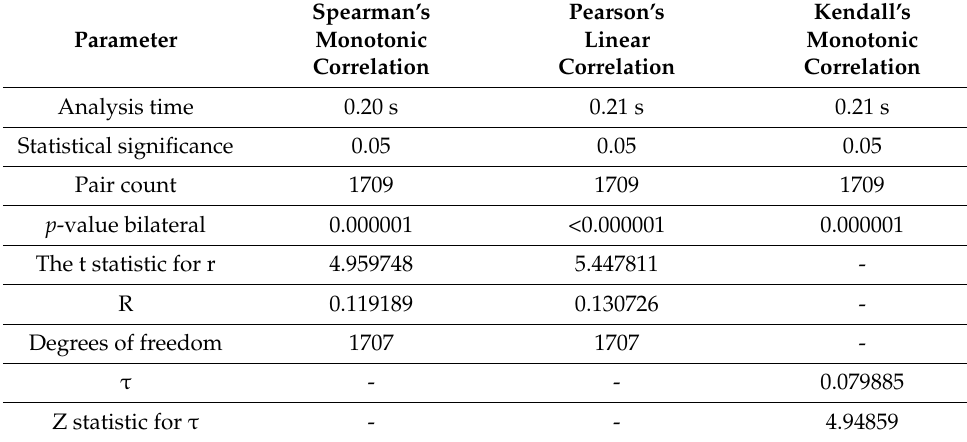
Table 2. Summary of results.